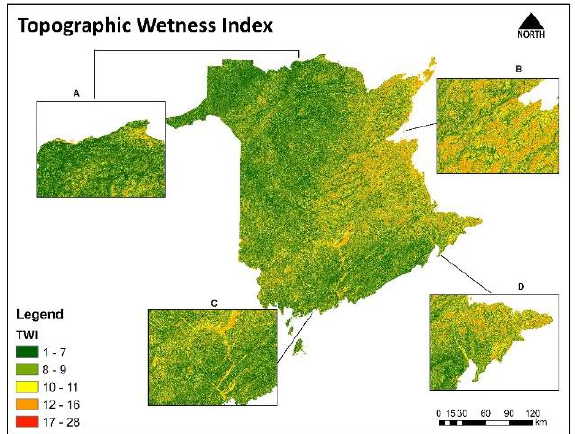
Figure A6. Topographic Wetness Index.